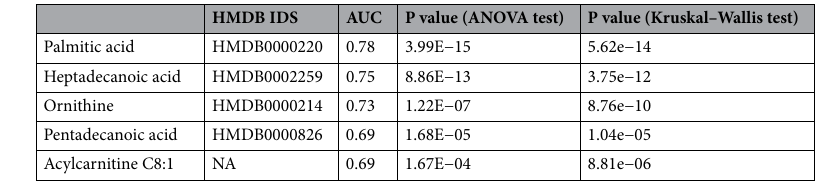
Table 5. Most significant biomarkers for discriminating different lung cancer